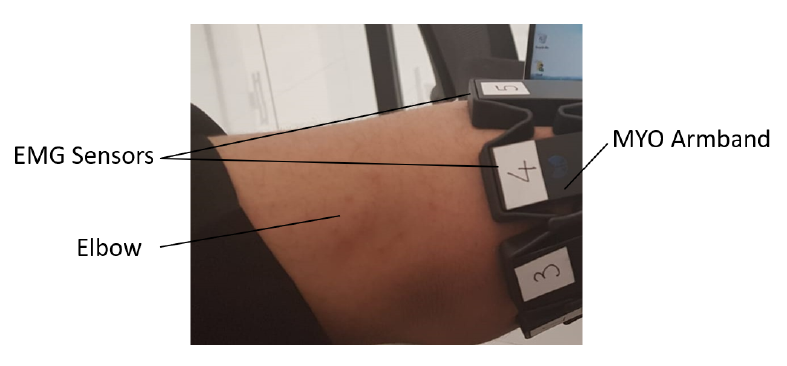
Figure 1. Amputation case with the user wearing a Myo armband.